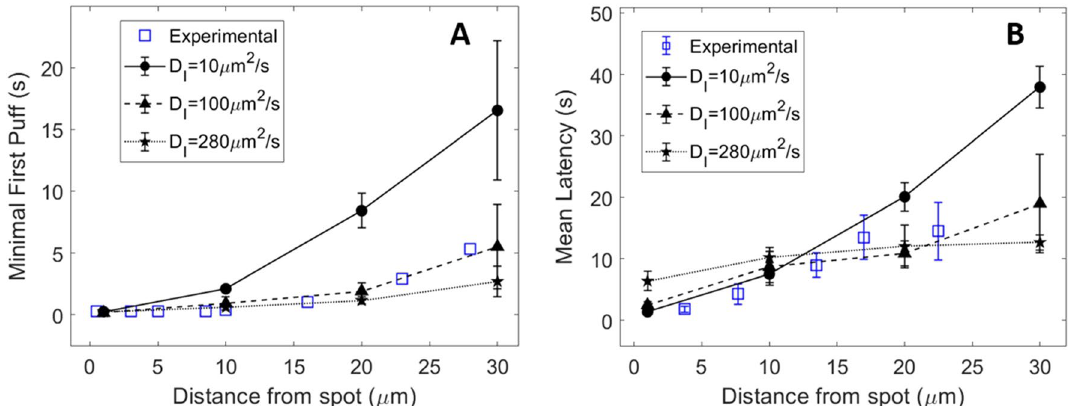
Figure 5. Comparison between puff latencies theoretically predicted with the rate of IP 3 release θ = 250 μm 2 s −1 and observed by Dickinson et al. 11 . Panels ( A and B) show minimal first puff latencies and mean latencies simulated with different values of the effective diffusion coefficient for IP 3 , D I . All points correspond to a 200 ms flash. Plain symbols are theoretical predictions while empty symbols are the experimental observations of Dickinson et al. 11 . Lines are drawn between simulation results. Simulations are performed in a 2D ellipse-shaped system with the spot of IP 3 release being a 0.25 μm radius disk at one extremity of the simulated cell. For each theoretical point, 50 independent simulations were run. Error bars indicate ± SEM. For minimal first puffs, the 50 simulations were divided in 10 groups of 5 simulations among which the minimal first puff was considered.